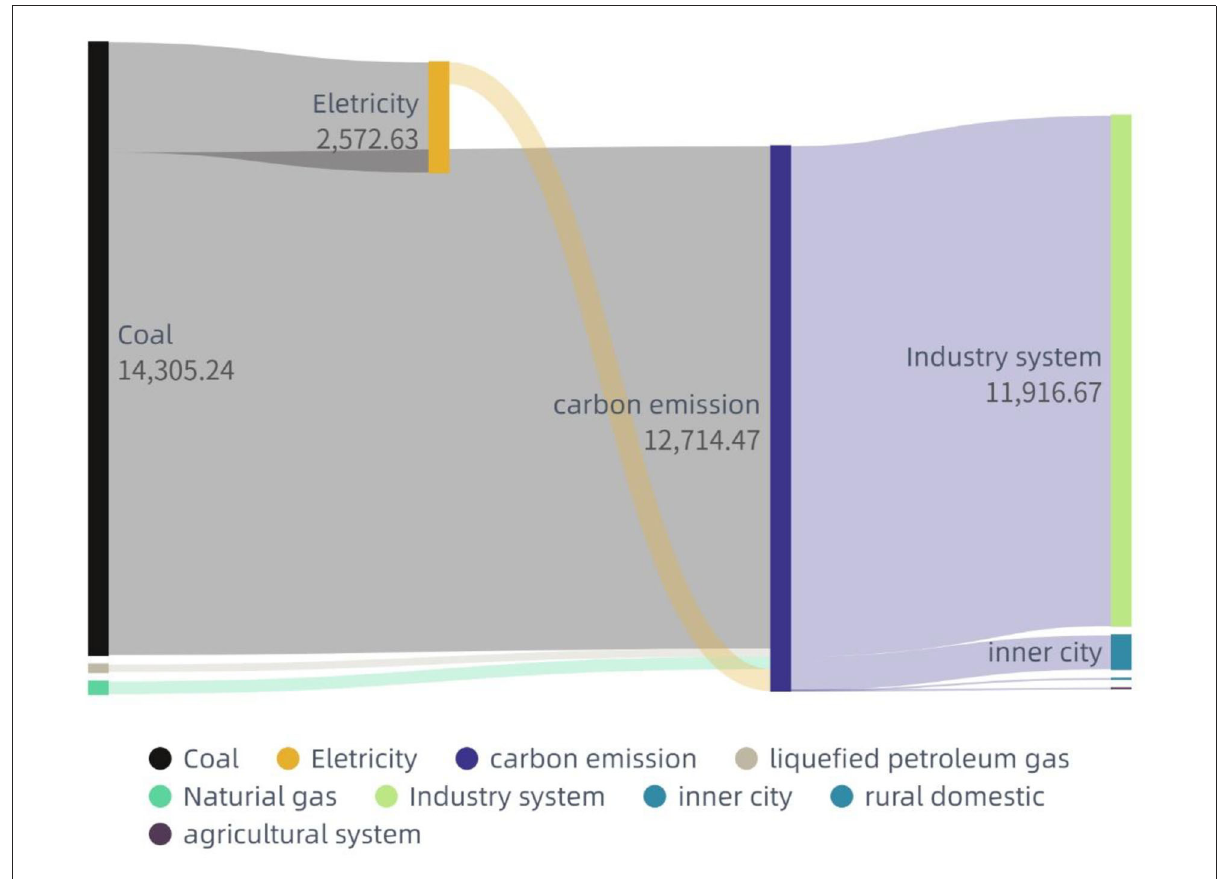
FIGURE6 The carbon emission characteristics in